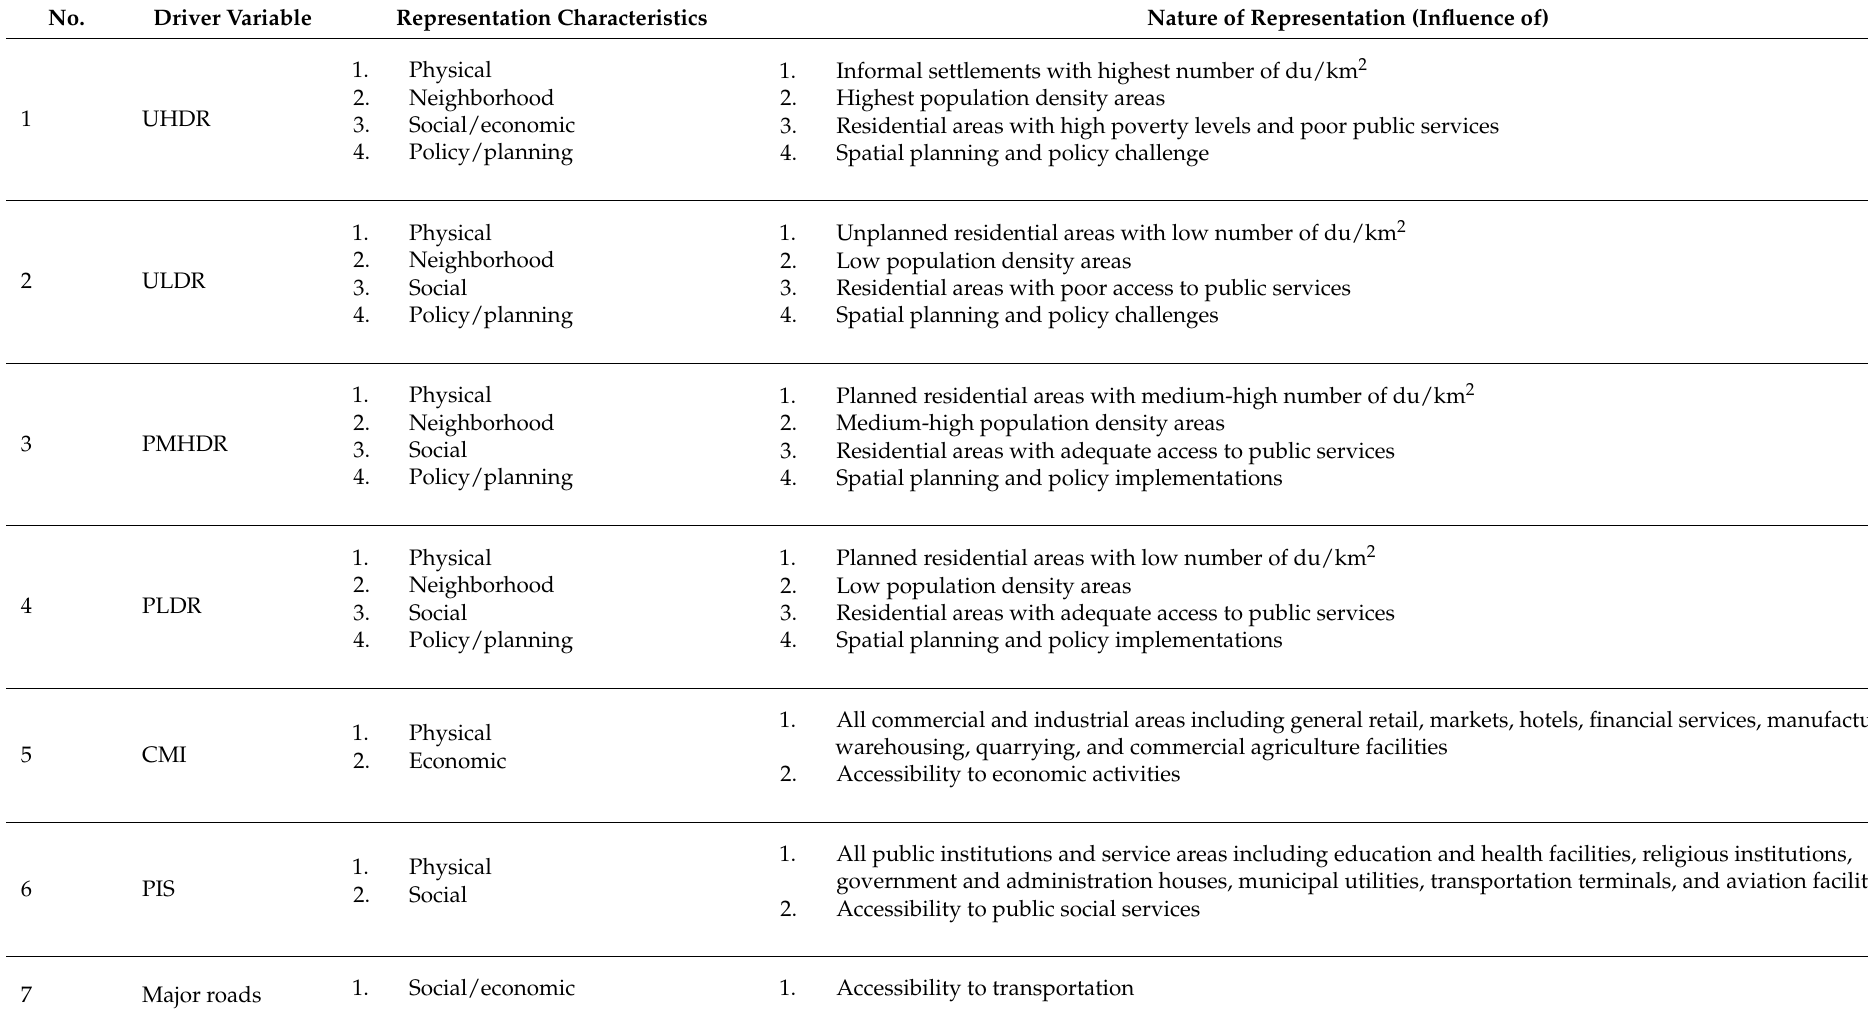
Table 2. Representation characteristics of driver variables (refer to Figure 3 for